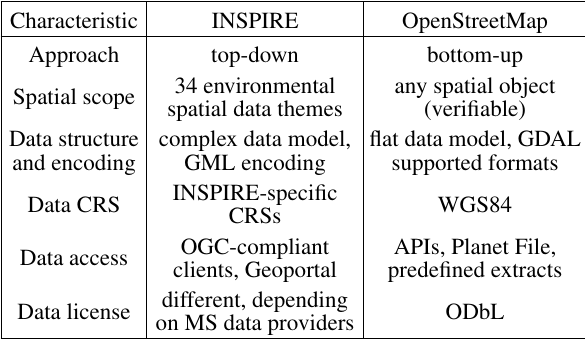
Table 1. Synthesised comparison between INSPIRE and